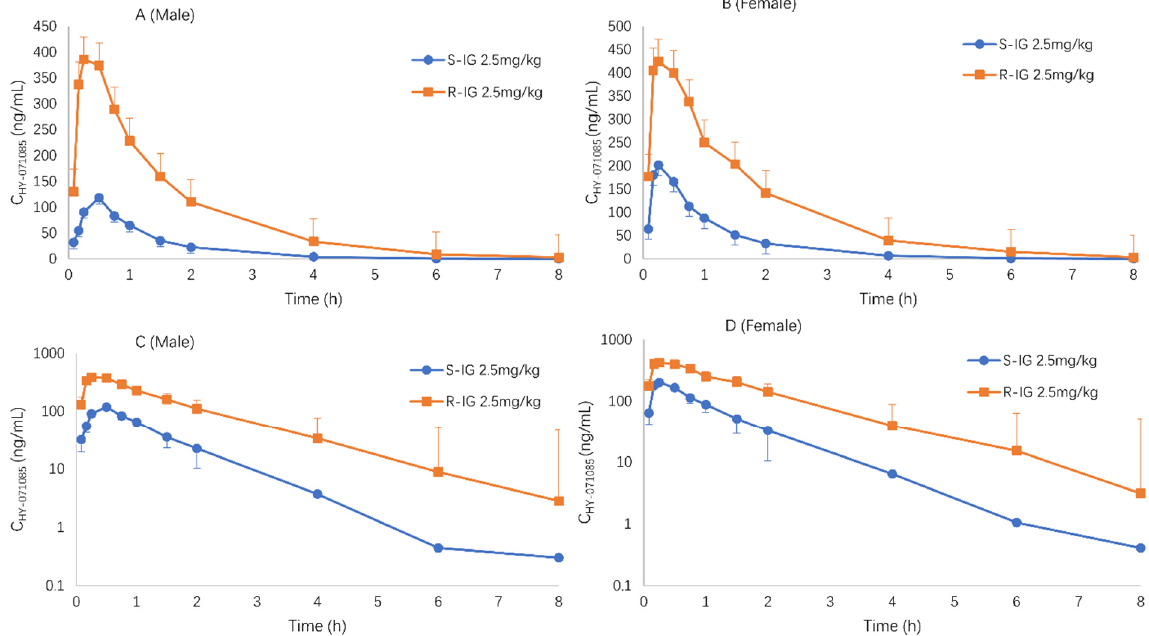
Figure 11. Comparison of the mean plasma concentration–time curves of HY-071085 after single and repeated intragastric doses of 2.5 mg/kg in beagle dogs. ( A , B ) Constant coordinates; ( C , D ) semilogarithmic coordinates ( n = 8).